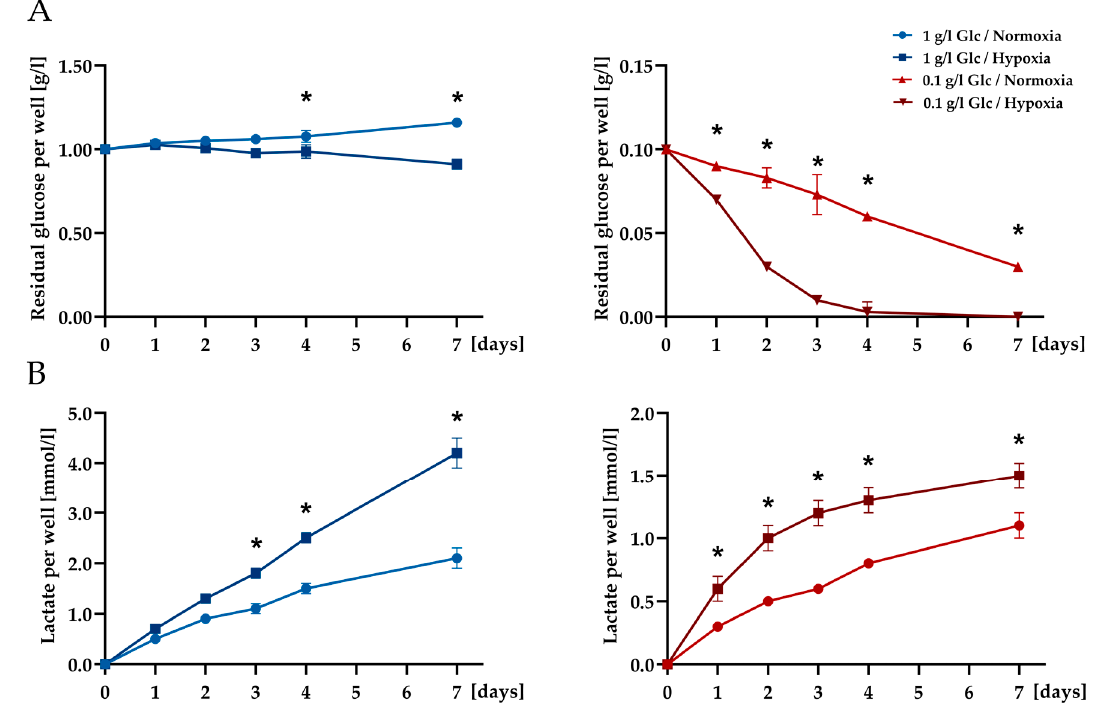
Figure 3. Glucose consumption and lactate production of ASCs cultured with 1 or 0.1 g/L glucose exposed to 21% or 0.2% oxygen over seven days. ( A ) Time course of exogenous glucose levels in the supernatant media (per well). ( B ) Time course of lactate production (per well). Data are presented as means ± SD, n = 3; * p < 0.05.